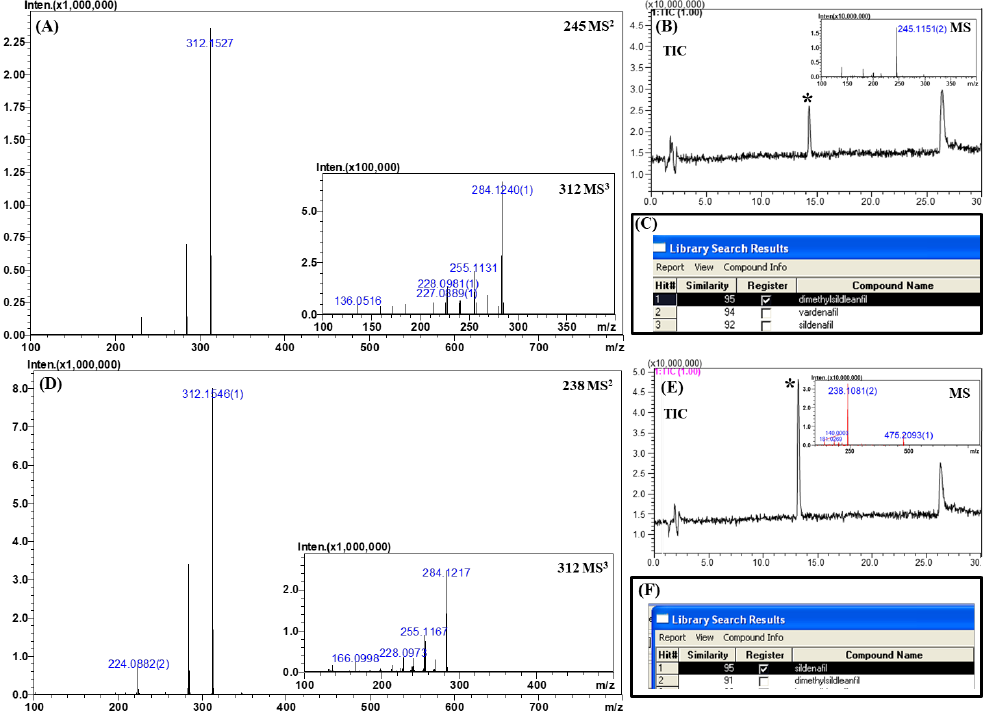
Figure 6. MS n ( n = 2, 3) spectra, total ion chromatograms, and library search results for real samples. ( A ) MS 2 and MS 3 spectra of sample 1, ( B ) chromatogram and corresponding MS spectrum of sample 1, ( C ) library search result for sample 1, ( D ) MS 2 and MS 3 spectra of sample 2, ( E ) chromatogram and corresponding MS spectrum of sample 2, and ( F ) library search result for sample 2.